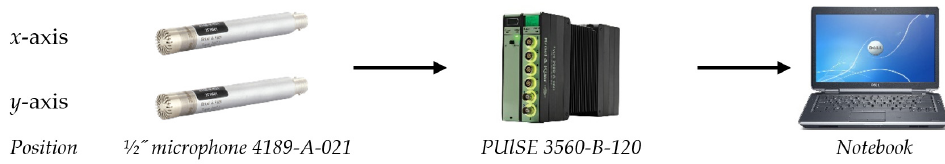
Figure 6. Measuring chain for noise measurement.